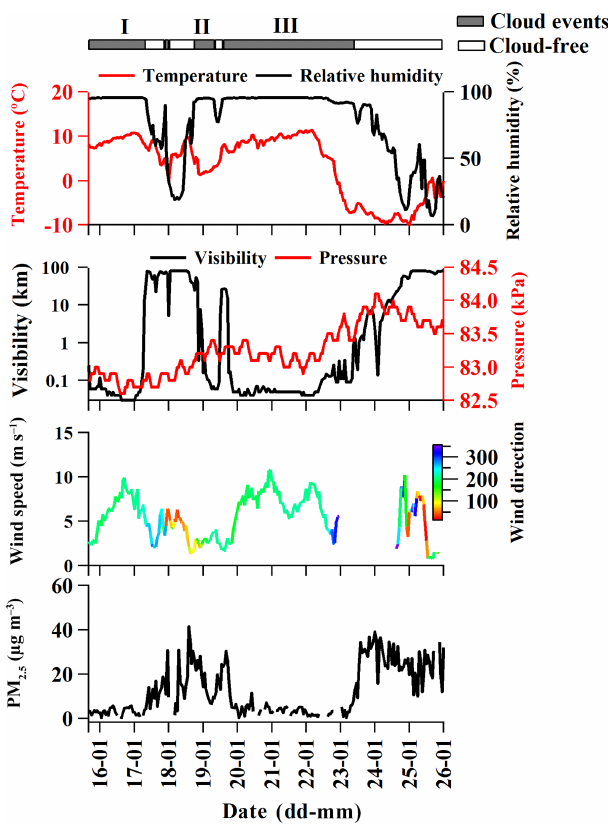
Figure 1. The hourly average variations in meteorological con- ditions (temperature, relative humidity, visibility, pressure, wind speed and direction) and PM 2 . 5